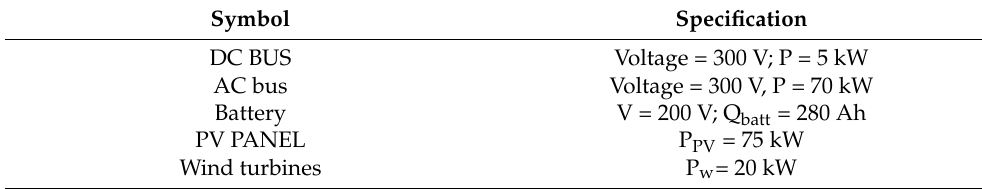
Table 3. Microgrid components